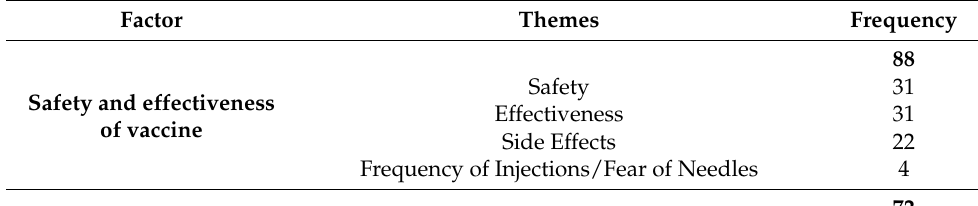
Table 3. Factors, their underlying themes, and the number of articles containing the factors/themes as extracted from the final 71